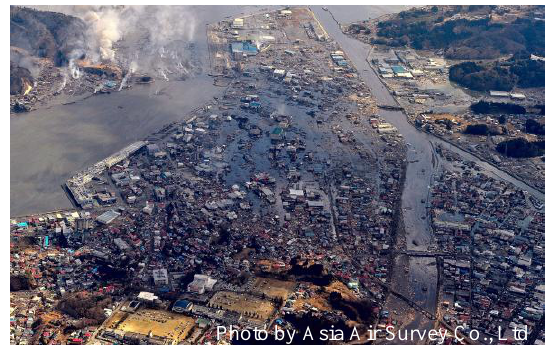
Figure 1. Kesen-numa city damaged by